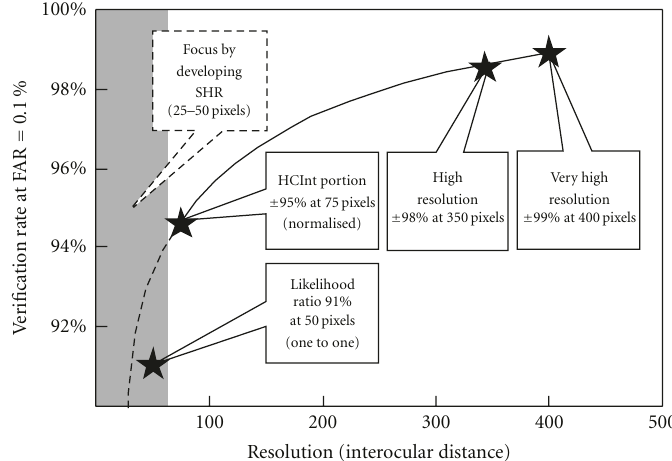
Figure 3: Best verification rates reported during the FRVT 2006. Our focus is at even lower resolutions (grayed area) expecting a slightly lower verification rate.